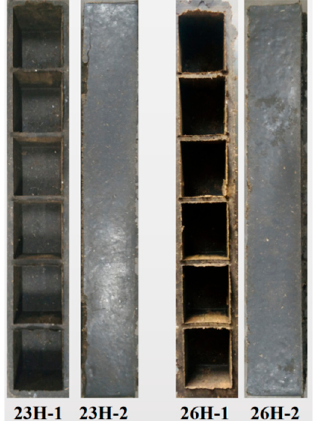
Figure 7. Seedling tray compressed at a high temperature. Note: The 23 and 26 represent water content of 23% and 26%, H means the seedling trays were compressed at high temperature. The “-1” and “-2” represent top view and side view, respectively.